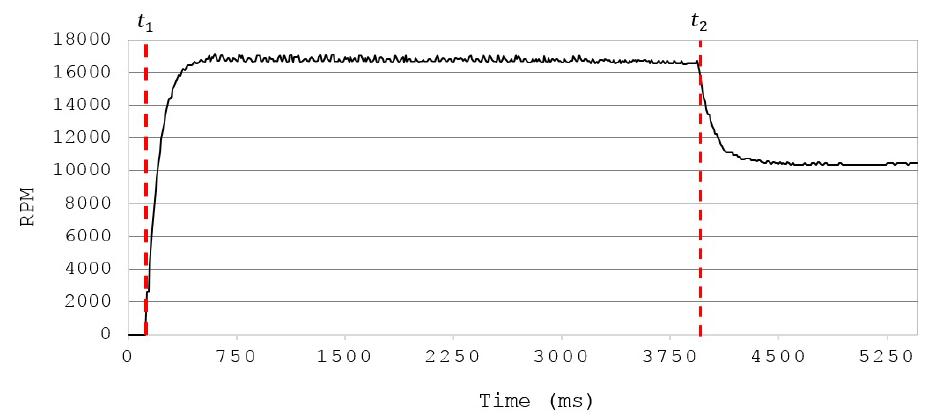
Figure 2. Step response of the actuators for transfer function